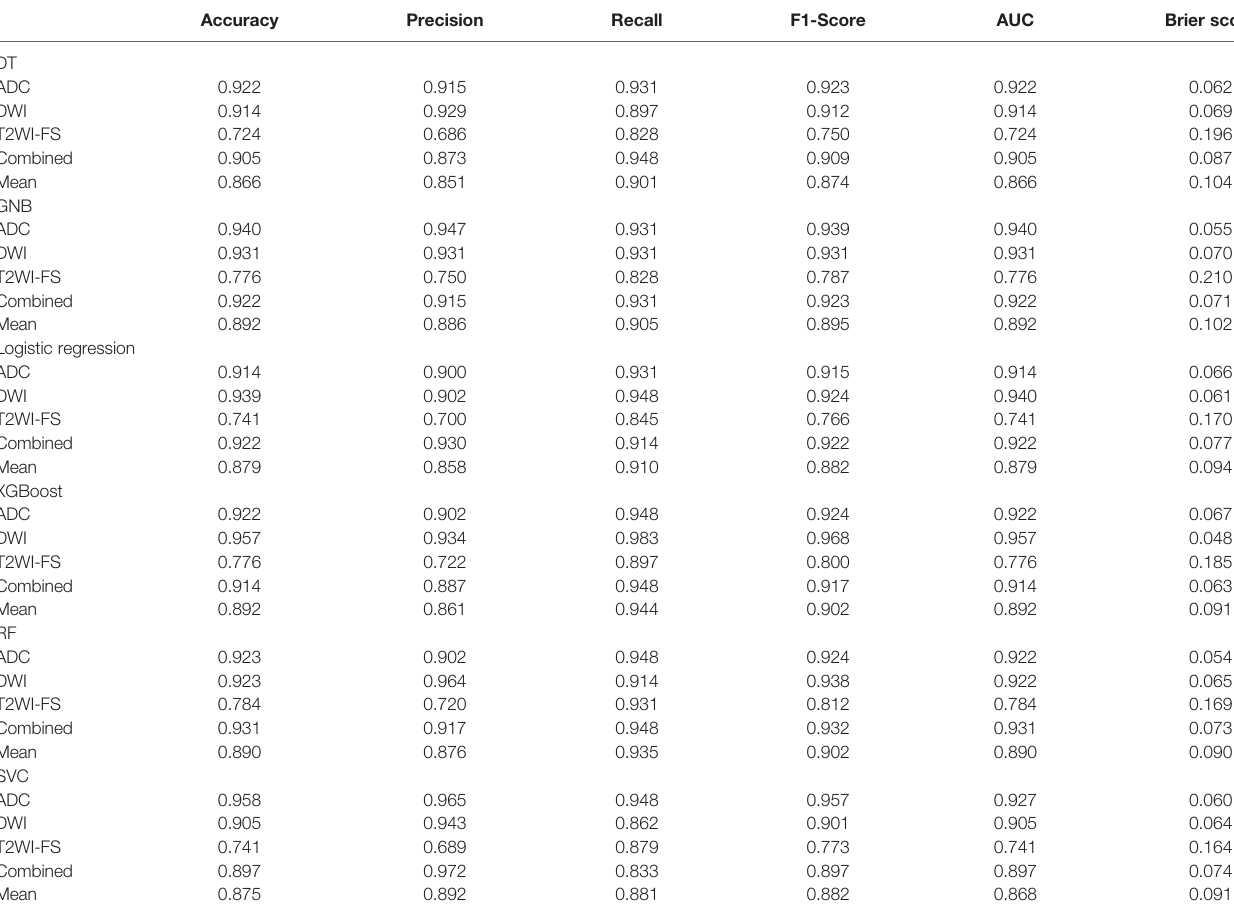
TABLE 5 | Accuracy, precision, recall, F1-score, AUC, and Brier score results of mpMRI and combined models based on lesions for predicting PCa. Accuracy Precision Recall F1-Score AUC Brier score